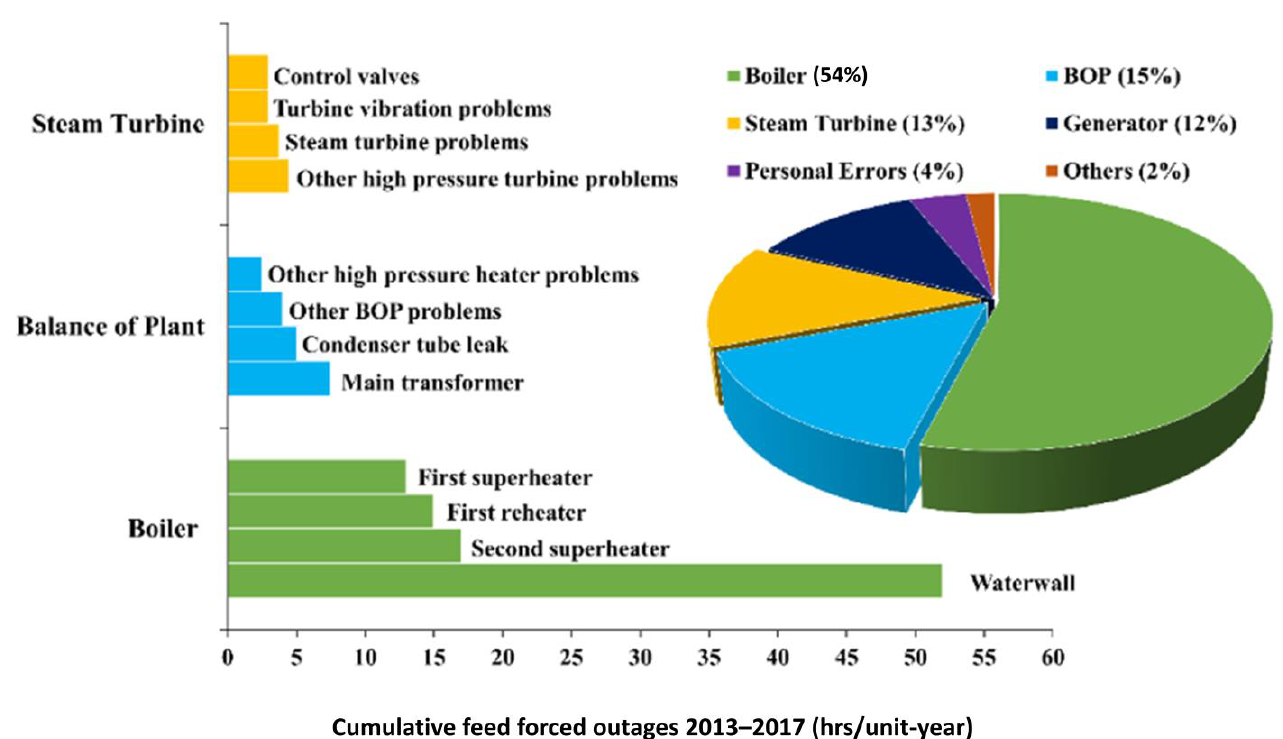
Figure 1. Graph Depicting the Severity of Power Plant Faults and their Resulting Percentage of Outages [22].